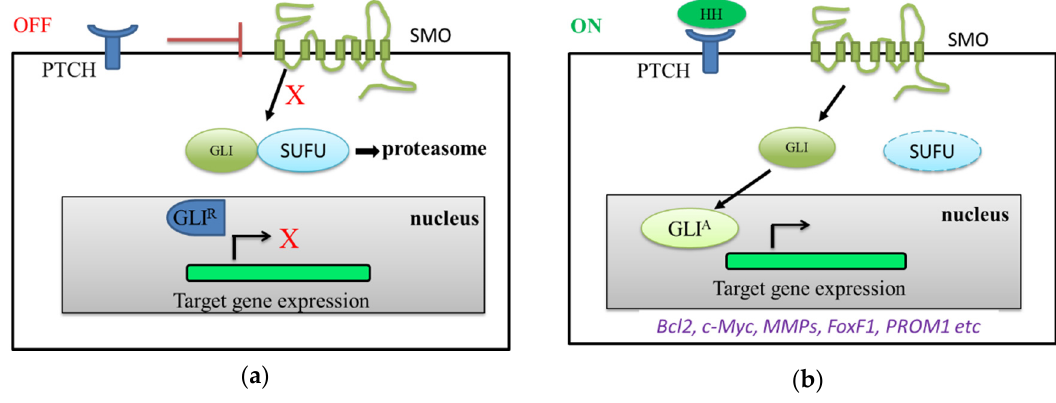
Figure 1. Canonical Hedgehog (HH) signaling pathway. ( a ) OFF state: PTCH inhibits Smoothened (SMO) activity, and transcription factor GLI and SUFU are proteolytic by proteasome. The GLI repressor form (GLI R ) binds to target genes and there is no target gene expression. ( b ) ON state: HH ligands binds to PTCH to weaken the inhibition of SMO. SMO can then activate transcription factor GLI. The SUFU is removed from the binding to GLI. Therefore, GLI activator form (GLI A ) to regulate target gene expression related to Bcl2 gene for cell survival , c-Myc gene for cell proliferation, MMPs genes for migration/invasion, FoxF1 gene for angiogenesis and PROM1 for cancer stem cells.